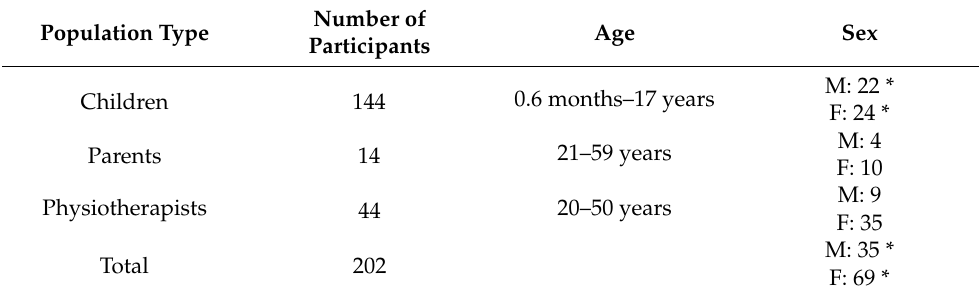
Table 5. Characteristics of the study